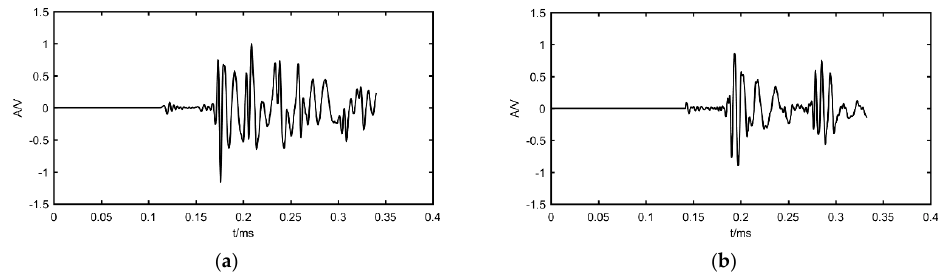
Figure 10. The comparison of AE signal acquired by simulation and experiment: ( a ) simulation signal; ( b ) experimental signal. Table 5. The average calculation time of two kinds of algorithm with different scanning accuracy. Scanning Accuracy